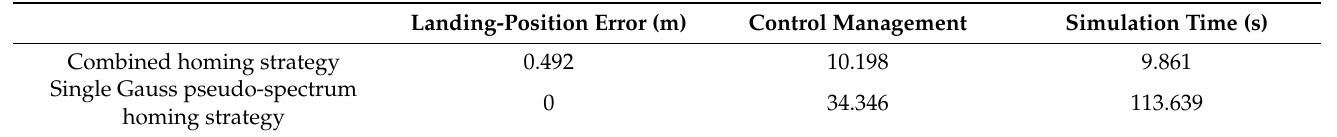
Table 3. Comparison of trajectory planning algorithm index